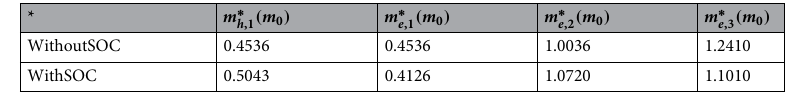
Table 1. Effective mass of electrons and holes for different bands with and without SOC.